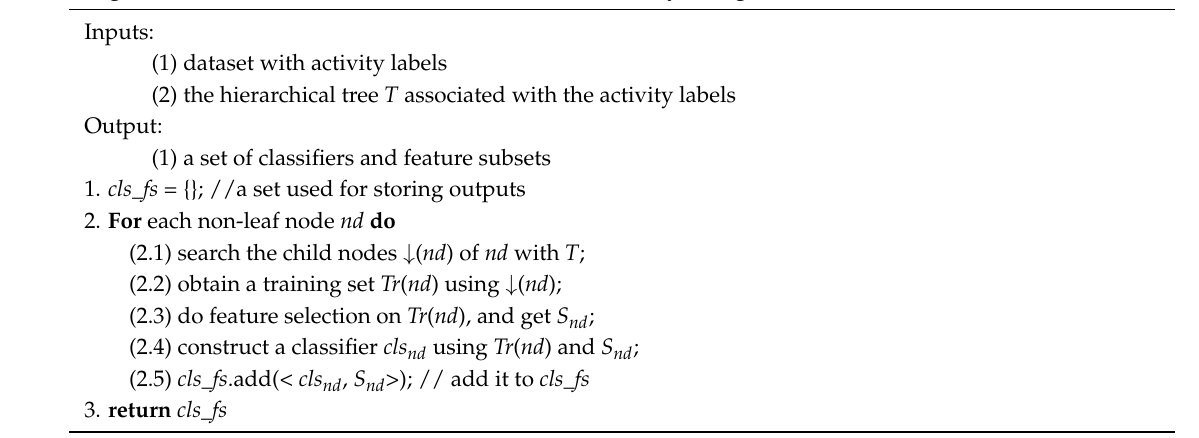
Algorithm 1. The Pseudo-code of the Hierarchical Activity Recognition Method